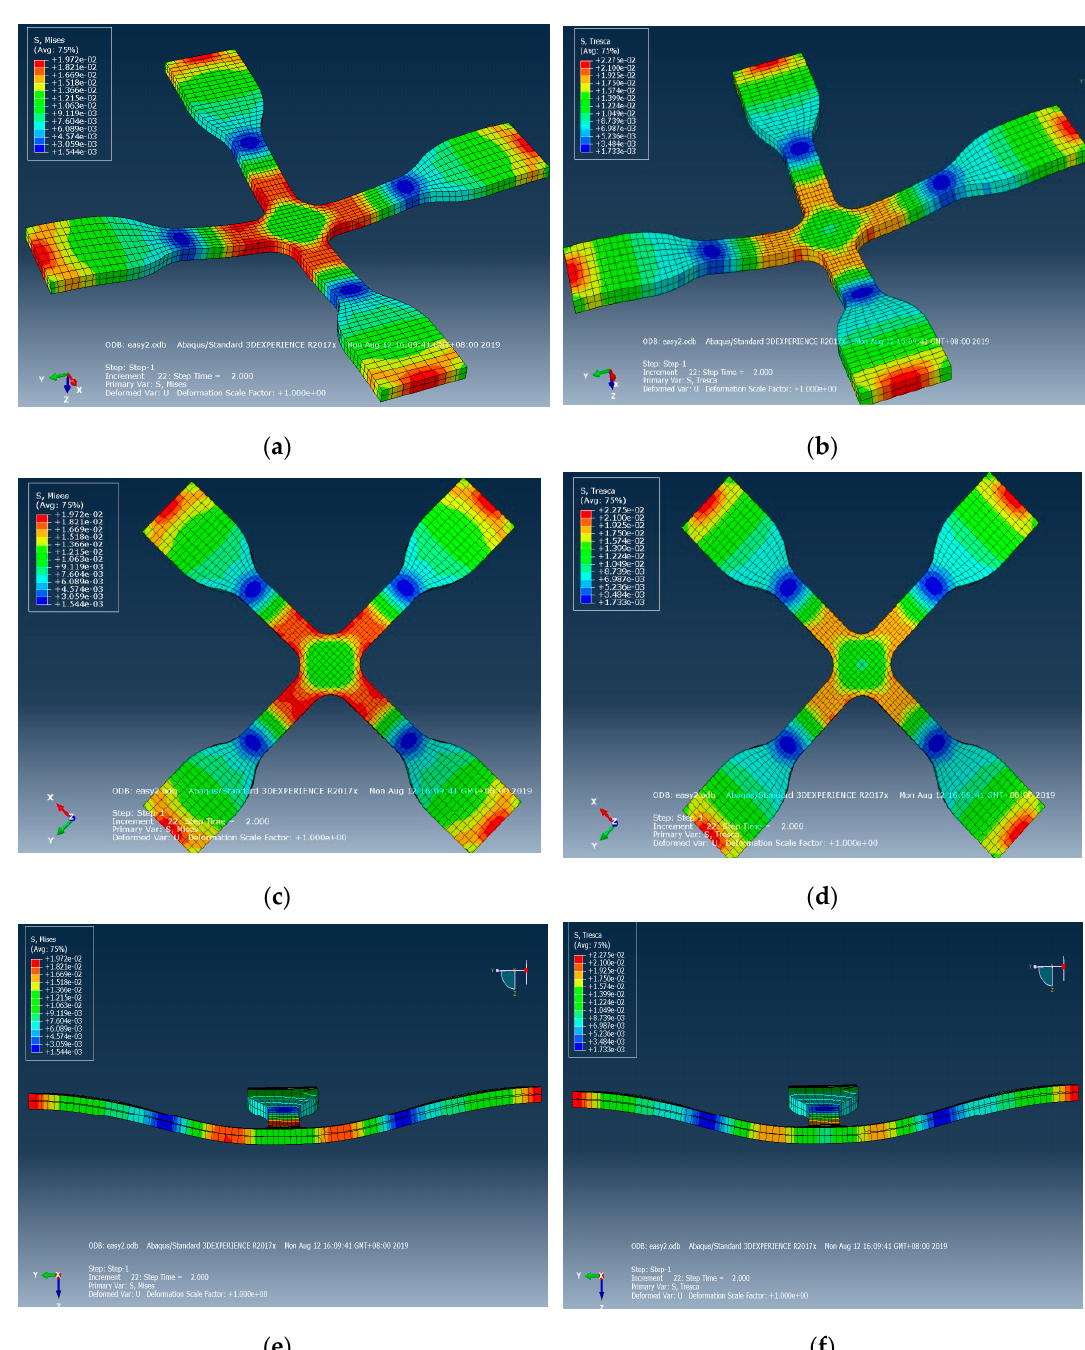
Figure 7. Cross-mold contact stress surface, microstructure surface, cross-section von Mises stress, and Tresca stress distribution simulation. ( a ) Stress surface (von Mises stress) ( b ) Stress surface (Tresca stress) ( c ) Microstructures surface (von Mises stress) ( d ) Microstructures surface (Tresca stress) ( e ) Cross section (von Mises stress) ( f ) Cross section (Tresca stress).